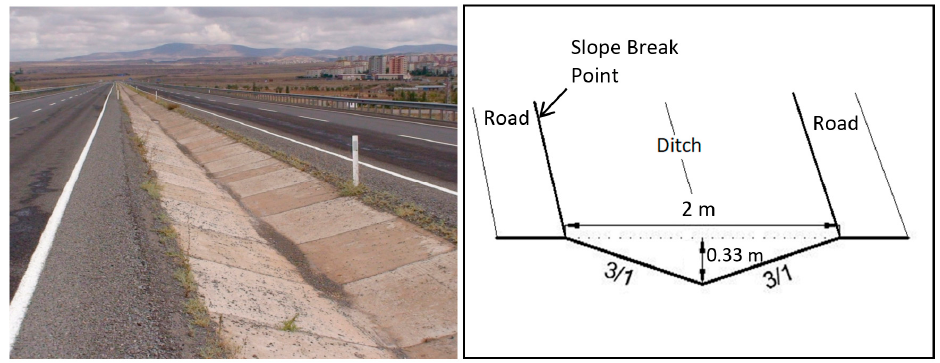
Figure 1. V-shaped ditch constructed at the median of divided highways in Turkey.